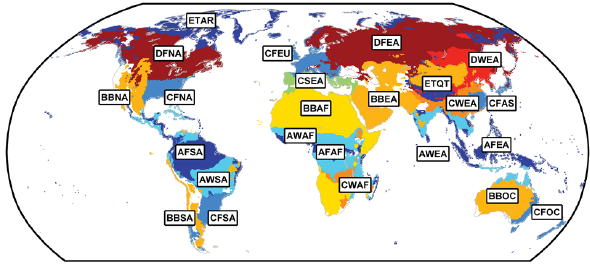
Fig. 1. Map of 24 regions used in our study. Abbreviations are ex- Figure 1 . Map of 24 regions used in our study. Abbreviations are explained in Table 1. 524 plained in Table 1. 525